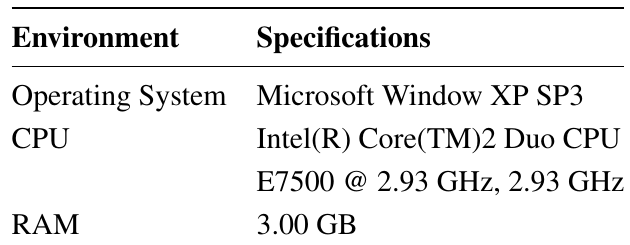
Table 1. Implementation and test